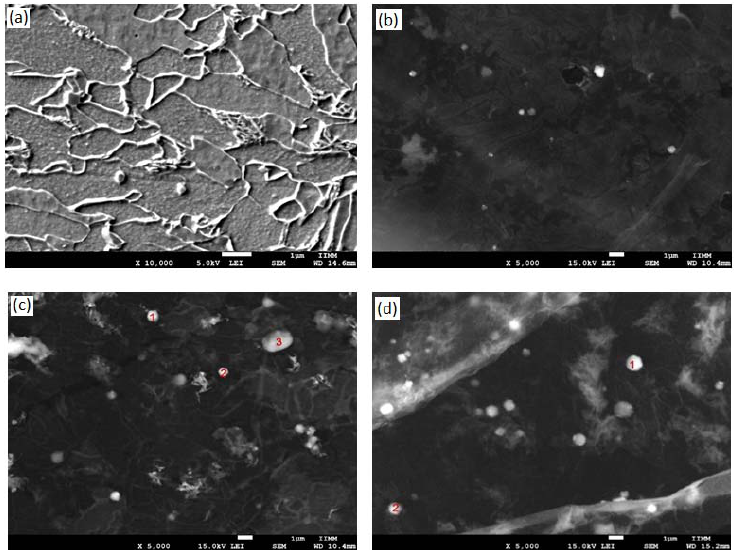
Figure 4. SEM micrographs of the ( a ) API ‐ X60 weldment that was over ‐ aged at 300 °C for three different aging times of ( b ) 6 h, ( c ) 15 h and ( d ) 30 h, respectively, showing fine Fe 3 C and Fe 2 C precipitates that were homogeneously distributed in ferritic grains.